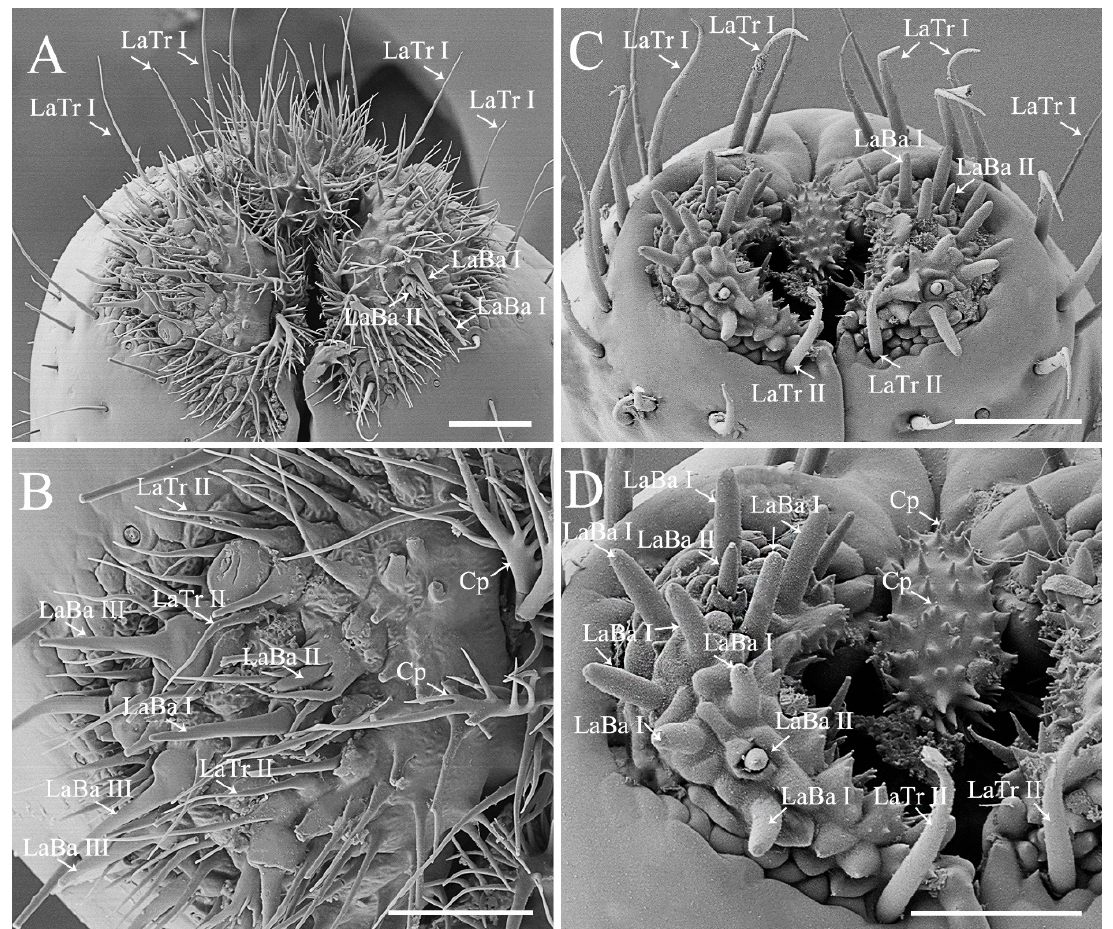
Figure 5. Labial apex of Eocanthecona furcellata ( A , B ) and Eurydema dominulus ( C , D ), showing labial sensilla and cuticular projections. Scale bars: ( A , C ) 30 μ m; ( B , D ) 20 μ m. Abbreviations: Cp, cuticular